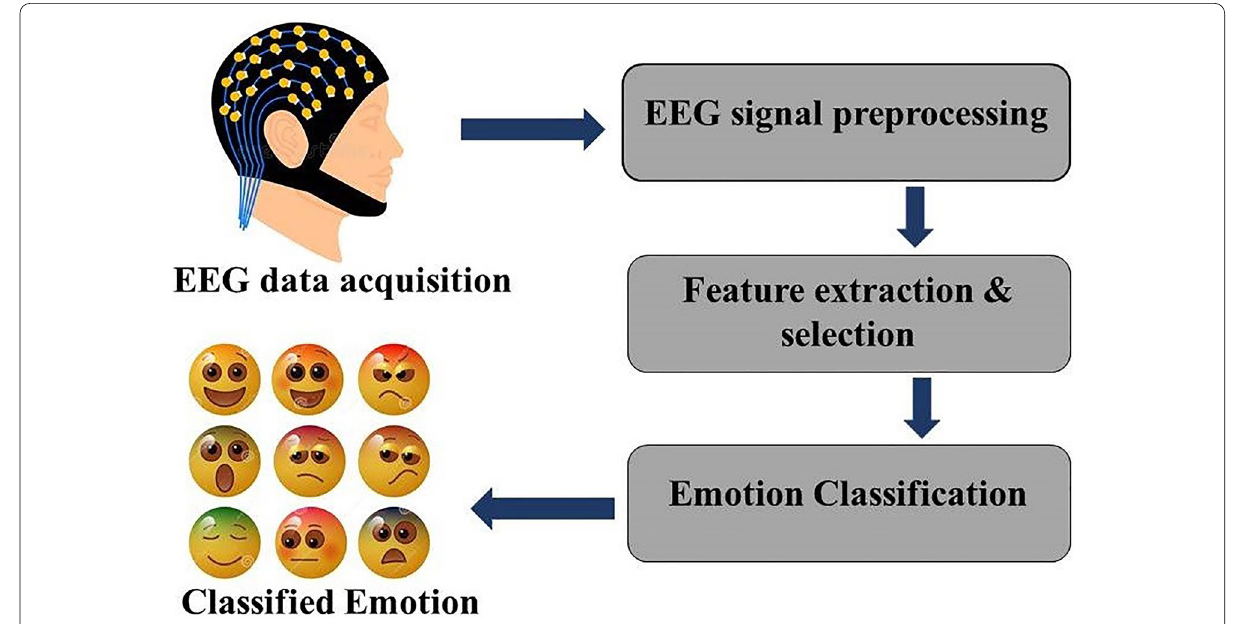
Fig. 1 Generalized block diagram of the proposed